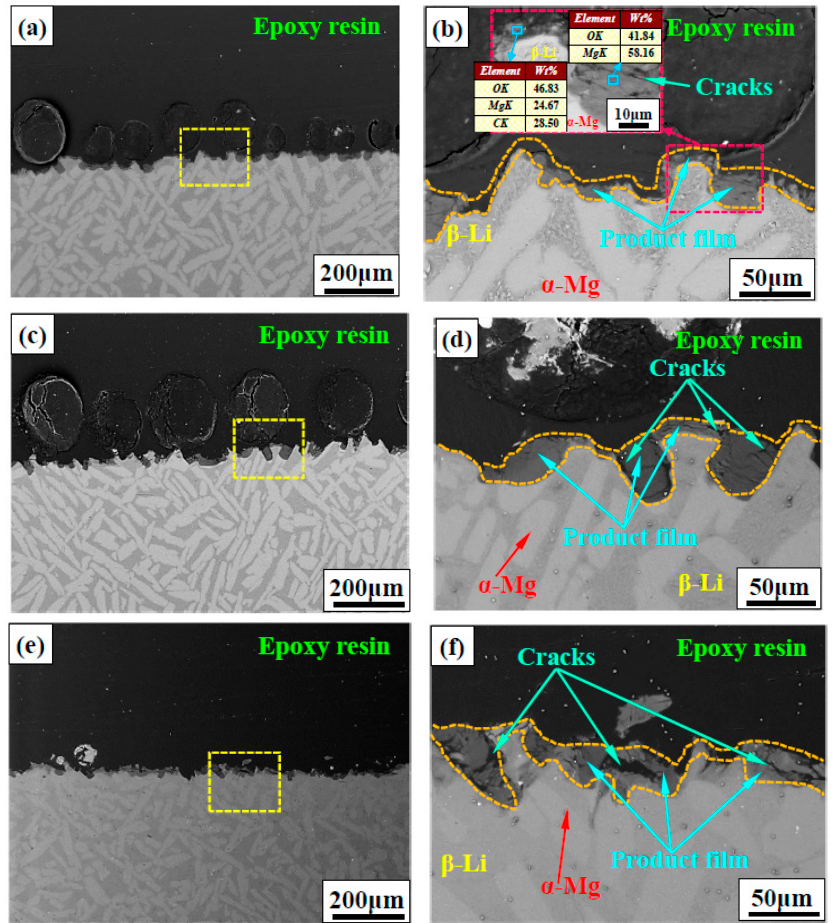
Figure 5. Cross-sectional morphologies of different samples after being hydrogen charged for: ( a ) 3 h, ( c ) 6 h and ( e ) 18 h. Images ( b ), ( d ) and ( f ) are high-magnified observations of the squared areas in images ( a ), ( c ) and ( e ), respectively.